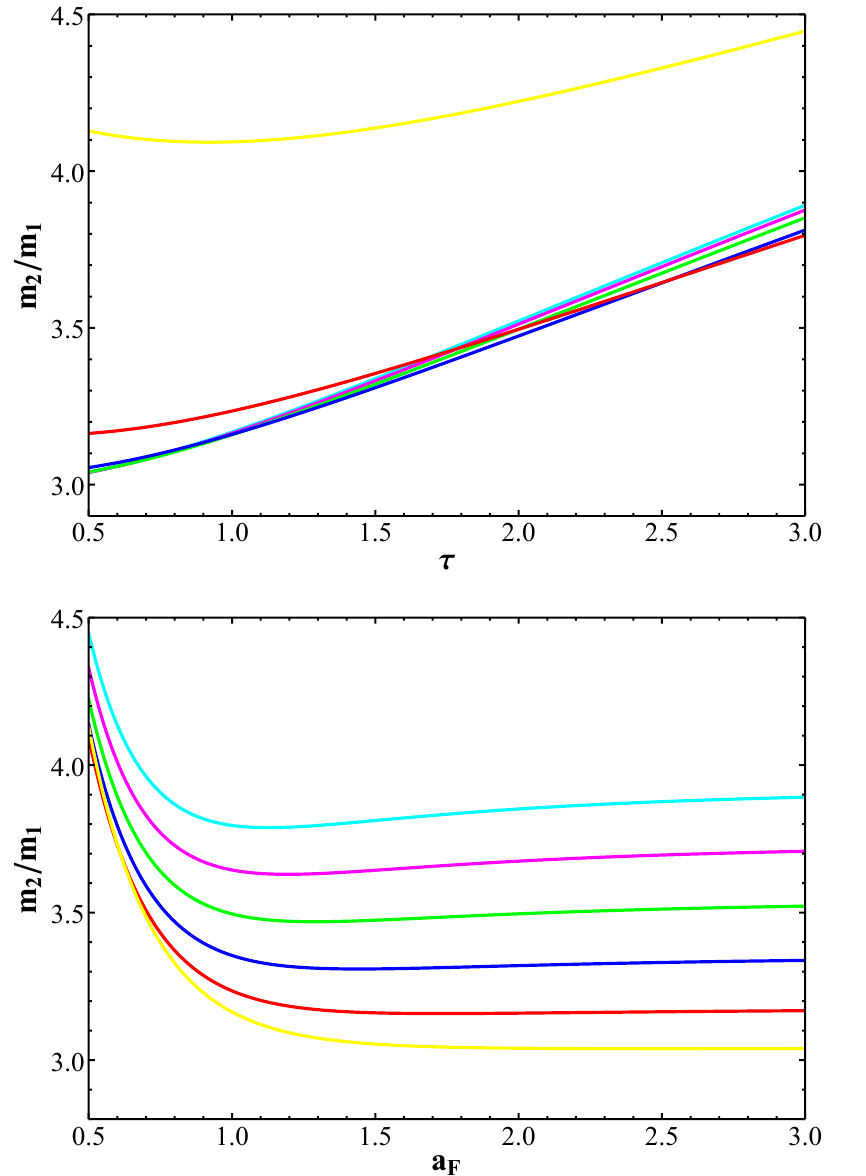
Figure 3 . (Top) The mass ratio of the lowest two dark photon KK states, m 2 /m 1 = x F a function of τ for a F = 3 (cyan), 5/2 (magenta), 2 (green), 3/2 (blue), 1 (red), and 1/2 (yellow), respectively. (Bottom) As in the previous panel, but now as a function of a F assuming τ = 3 (cyan), 5/2 (magenta), 2 (green), 3/2 (blue), 1 (red), and 1/2 (yellow),